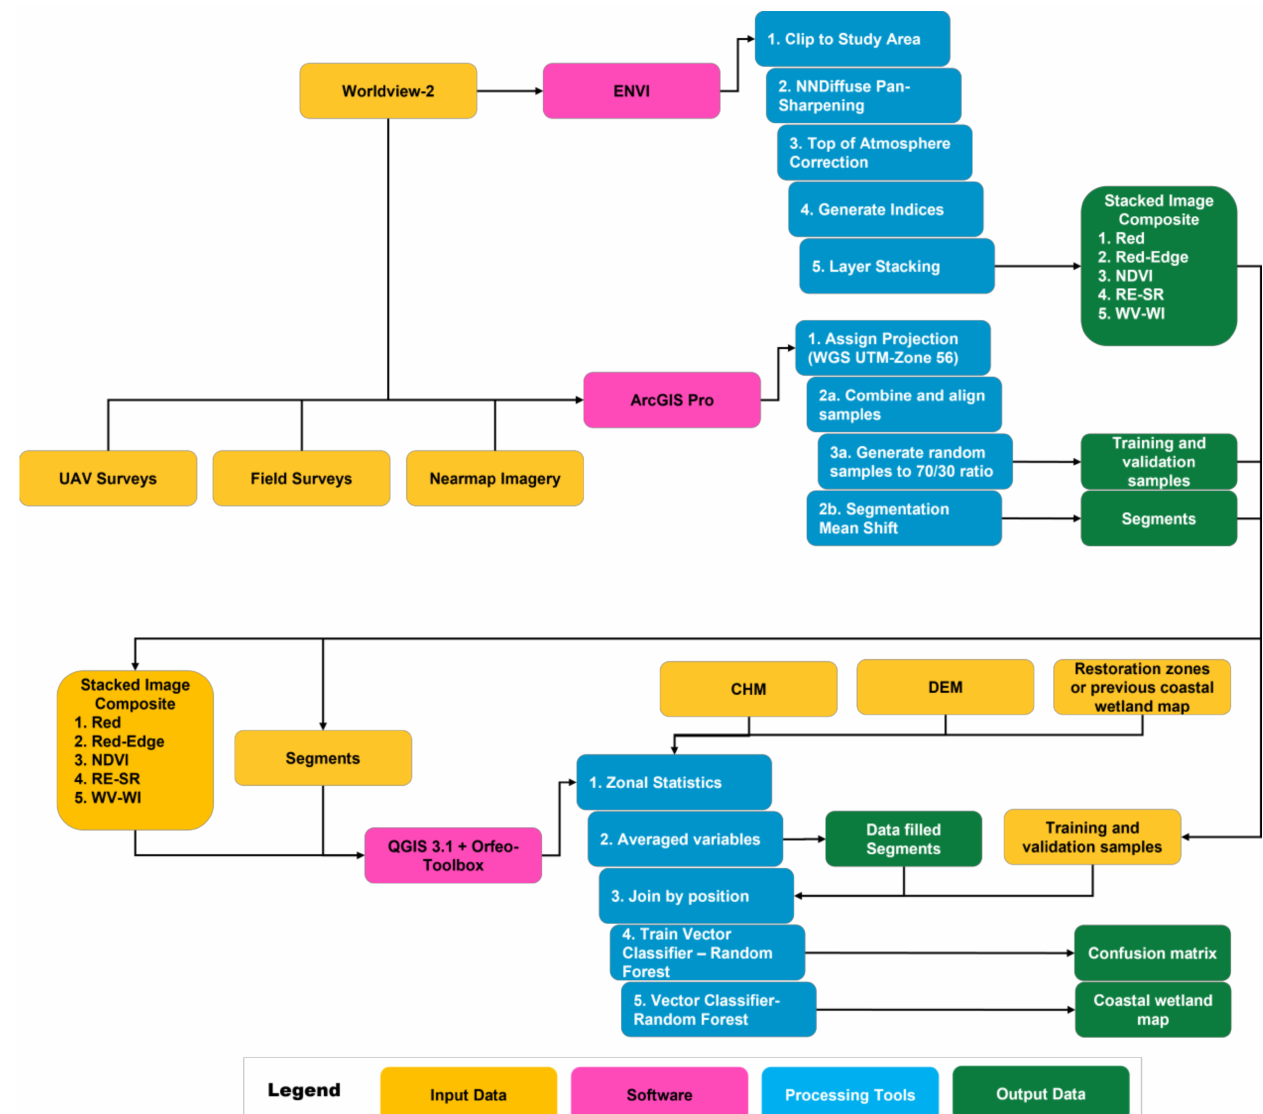
Figure 2. Methods workflow summarizing the combination of datasets, software packages and approaches used to classify land cover types for each